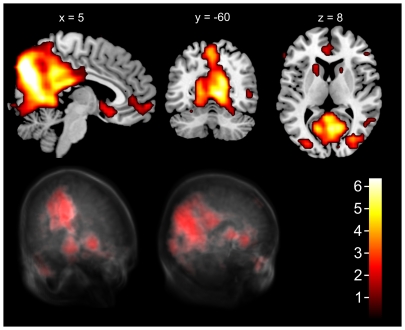
Default-mode network extracted by TICA.Top: sagittal, coronal and transversal view (Image displayed in radiological convention). Bottom: rendered 3d-view with transparent voxeldata from frontal-left- (left) and behind-left-view (right). Major clusters with coordinates, Z-score and Brodman area (BA) are: PCC (−4, −32, 28), Z = 5.86, BA 31 and (−6, −52, 12), Z = 3.87, BA 30; Precuneus (−8, −72, 28), Z = 6.44, BA 31; Cuneus (10, −74, 30), Z = 7.50, BA 18; Culmen (−8, −48, −4), Z = 3.09, BA 19; vACC (4, 16, −12), Z = 2.86, BA 25; Middle Frontal Gyrus (4, 60, −4), Z = 3.33, BA 10. Clusters exist left and right in similar size.